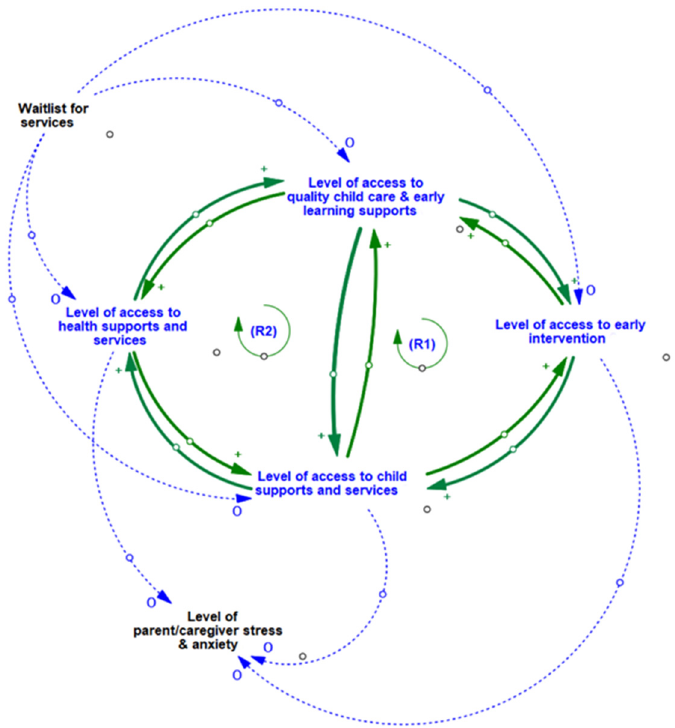
Figure 1. CLD of access points to a range of interconnected community services and program.